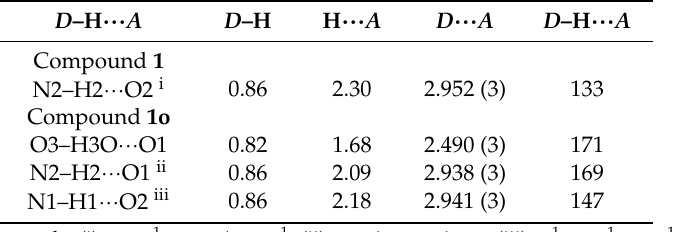
Table 3. Hydrogen bond geometry (Å, ◦